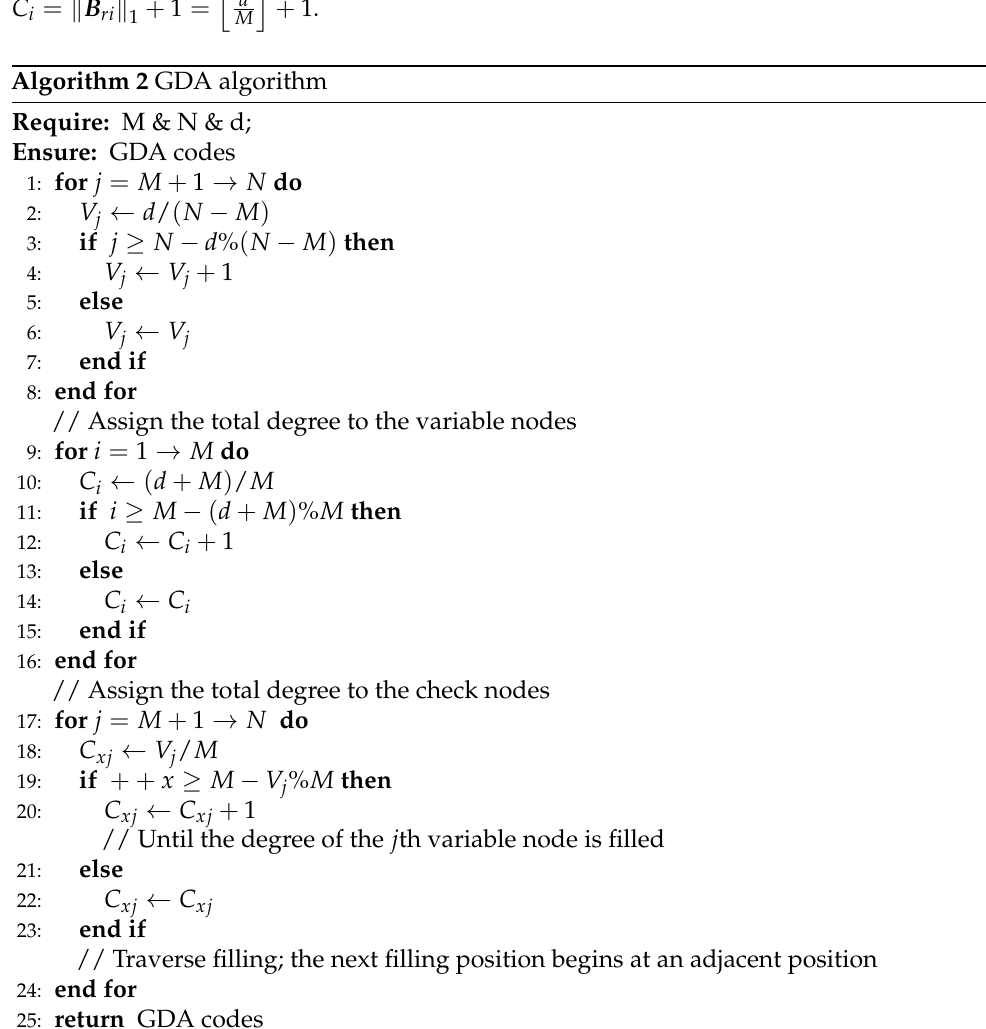
Algorithm 2 GDA